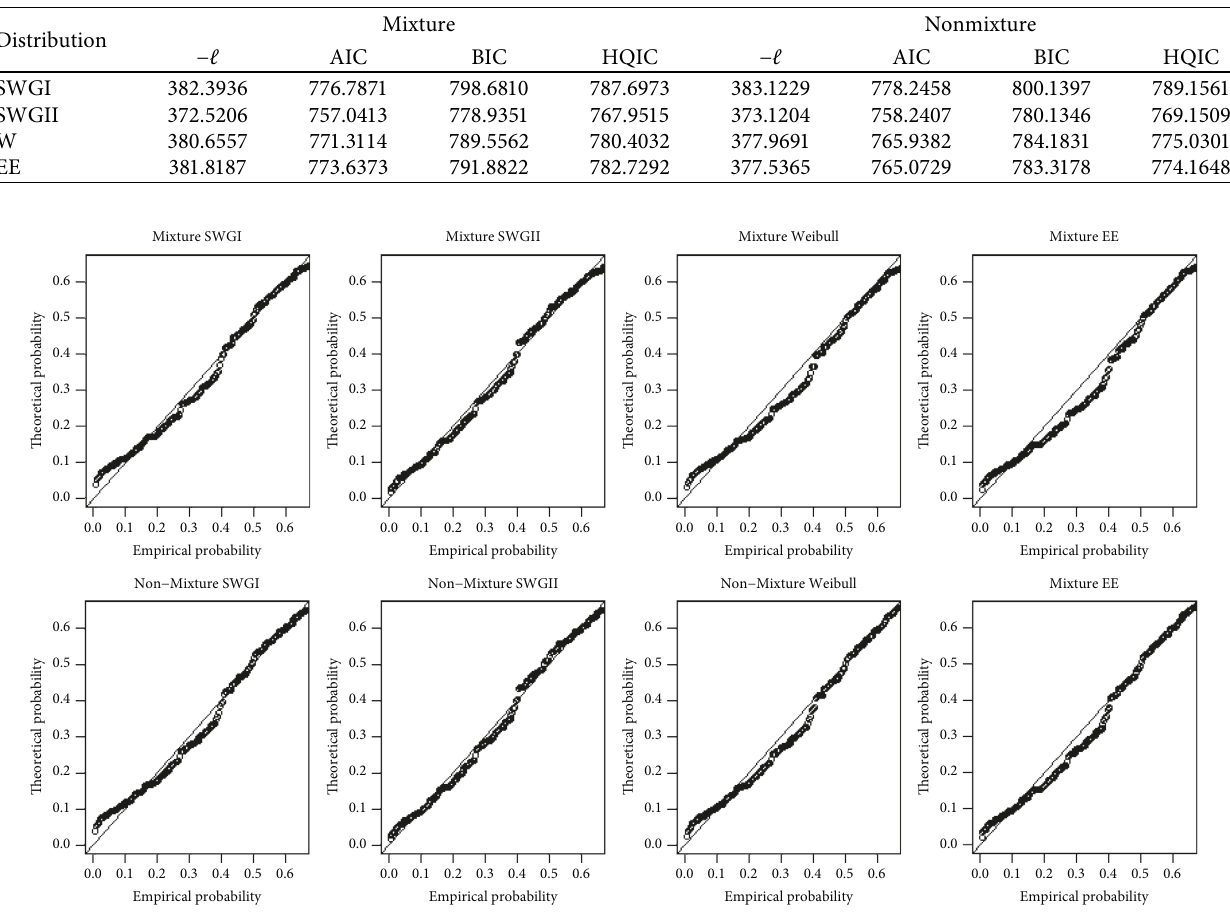
Figure 6: Cox–Snell residuals of fitted regression